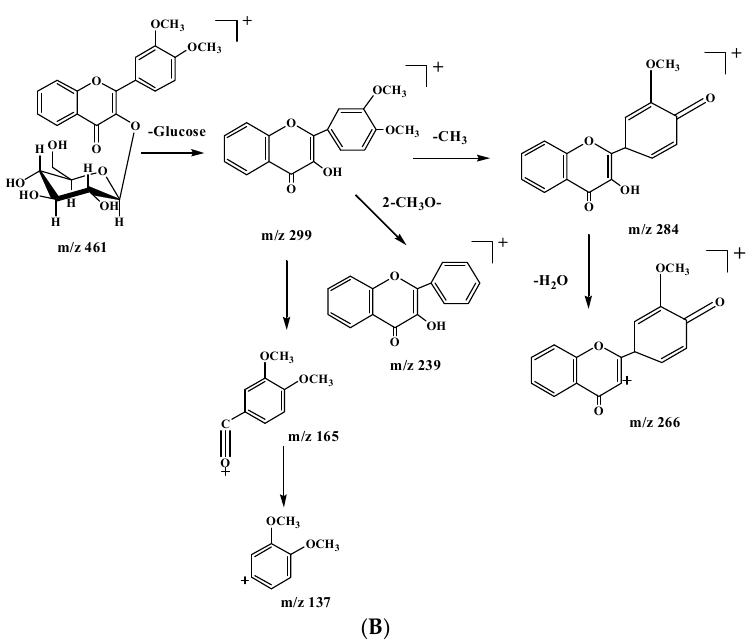
Figure 2. Mass spectrum ( A ) and fragmentation pathway ( B ) of DF3G in positive ion mode.